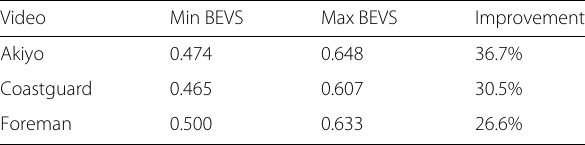
Table 7 Visual security improvement through the design space exploration based on the BEVS for three QCIF videos